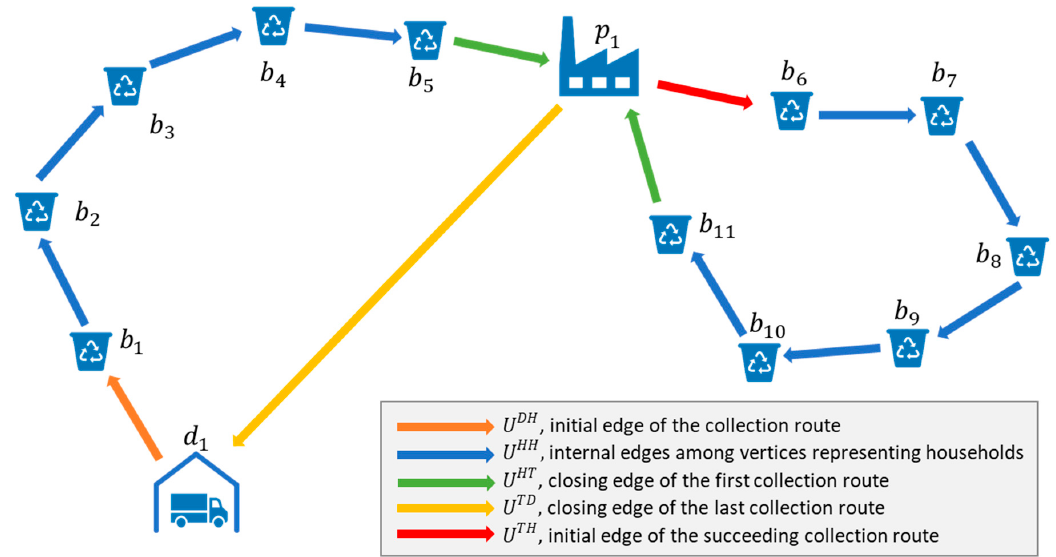
Figure 10. The collection route as a graph, where vertices represent the households, treatment sites, and garbage truck depots while edges correspond to transportation route.